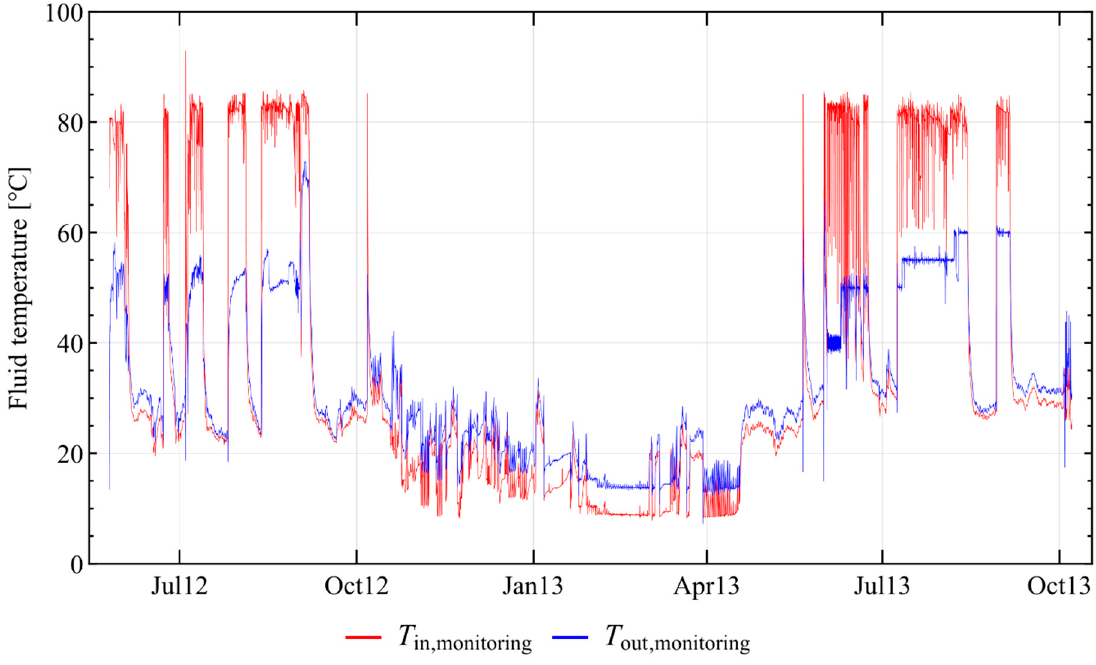
Figure 5. Measured inlet and outlet temperatures of the BTES system in Brædstrup during the first 500 days of operation.